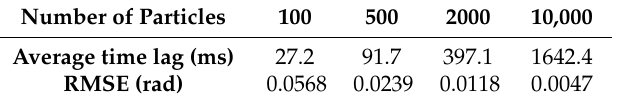
Table 3. Comparison of performance depending on the number of particles in real